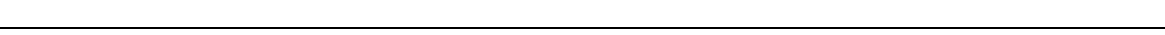
Fig. 1 Calcium signal dynamics reveal differential astrocyte responses to PV and SST interneuron activation. a Schematic of the in vivo experimental approach (left) and of the optogenetic stimulation of ChR2-PV or ChR2-SST interneurons (right). b Top, images of a representative GCaMP6f-astrocyte in layer 2/3 SSCx from an adult ChR2-PV-GCaMP6f mouse with the ROIs de fi ned by GECIquant software for the Ca 2+ response to the fi rst 30 light pulse stimulation (blue lines) of PV interneurons at the soma (yellow), proximal processes (red), and microdomains (blue), scale bar, 20 μ m (see Supplementary Movie 3). Bottom, Ca 2+ signal dynamics at different astrocytic compartments before and after successive 10 and 30 light pulse PV interneuron activations. Scale bars, 50 s, 20% d F / F 0 . c , d Raster plots of Ca 2+ peaks ( c ) and mean time course of Ca 2+ transients ( d ) from all in vivo monitored GCaMP6f- astrocytes, at rest and following PV interneuron stimulations. Scale bar, 5 s, 20% d F / F 0 . e – g Same as in b – d , but for ChR2-SST-GCaMP6f mice and